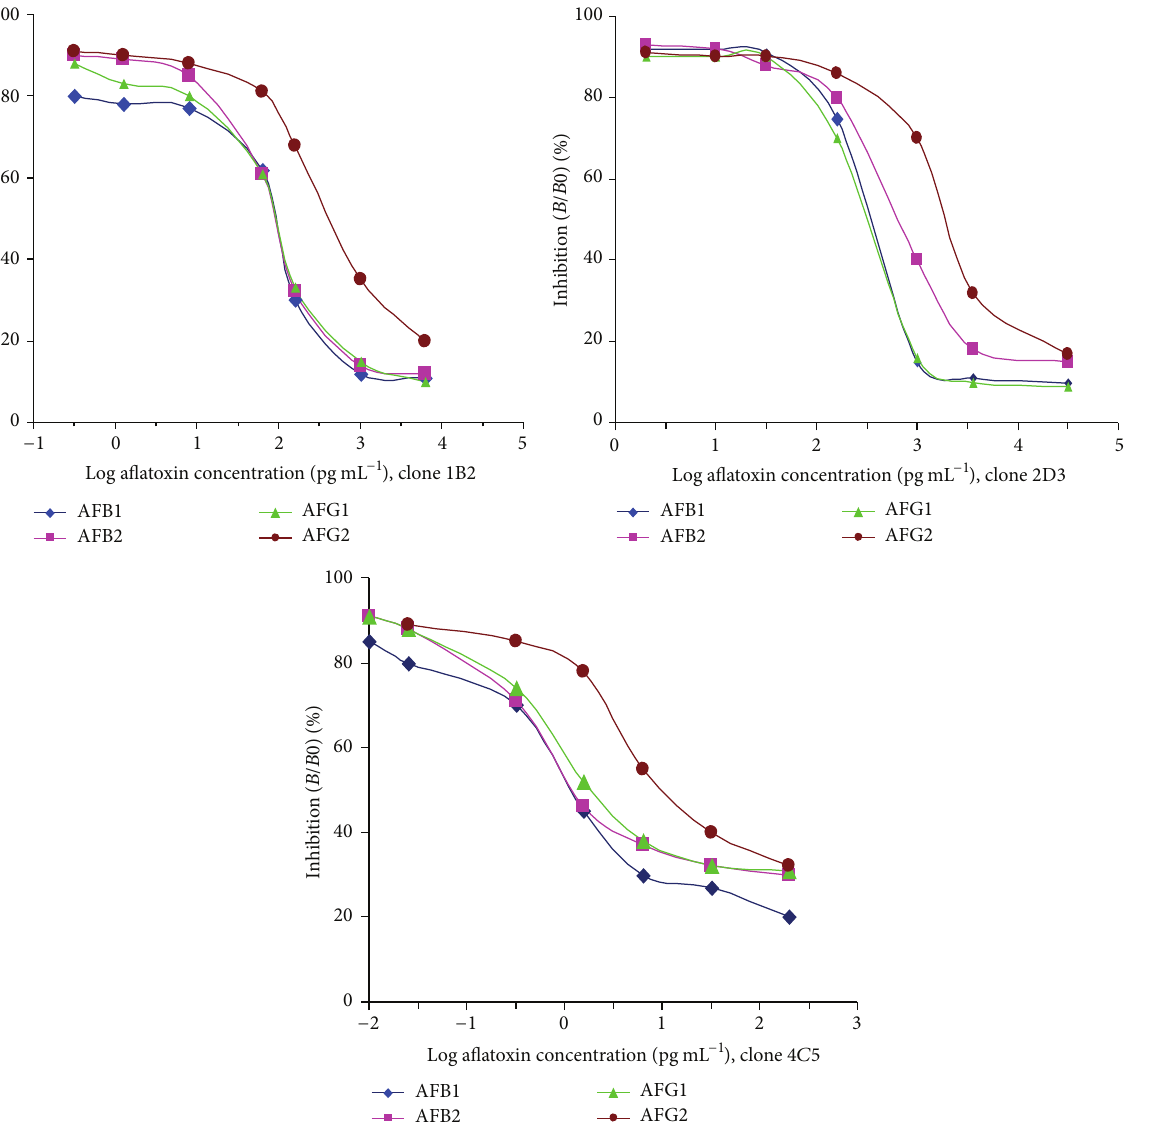
Figure 5: Cross-reactivity of three clones of monoclonal antibodies to four major